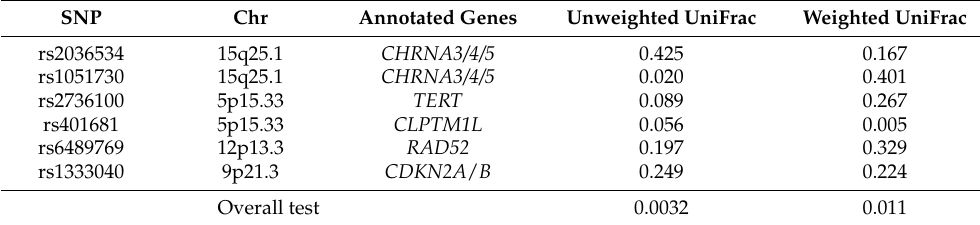
Table 2. Association p -values between lung cancer risk SNPs and microbiome composition in the EAGLE data. SNP Chr Annotated